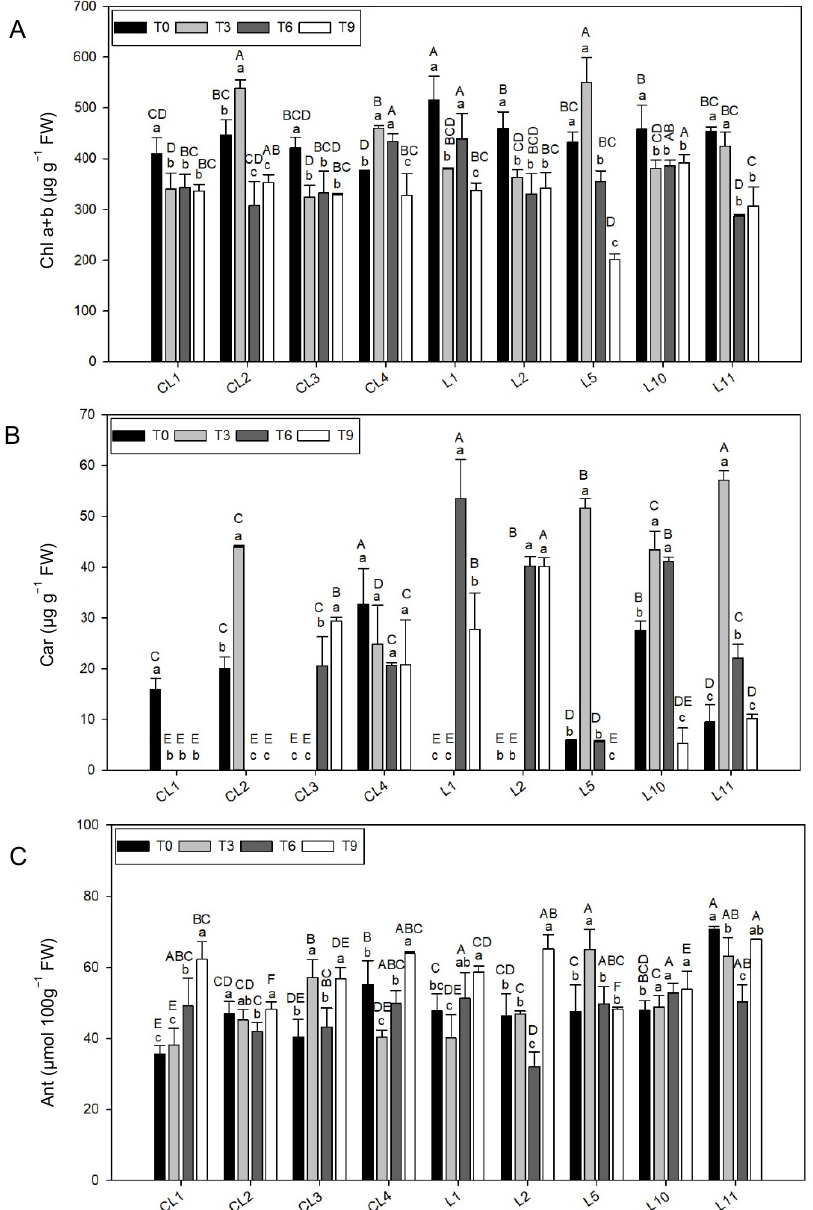
Figure 2. The ( A ) chlorophyll a + b (Chl), ( B ) carotenoid (Car) and ( C ) anthocyanin (Ant) concentra- tions in the nine lettuce varieties evaluated at 0 (T0), 3 (T3), 6 (T6) and 9 (T9) days after conservation under hamber conditions. Values are the mean ± SE of four replicates per landrace. The mean is subjected to a one-way ANOVA. Different capital and lowercase letters indicate significant differences between varieties and development stages, respectively, at p < 0.05 by the LSD test. FW: Fresh weight.